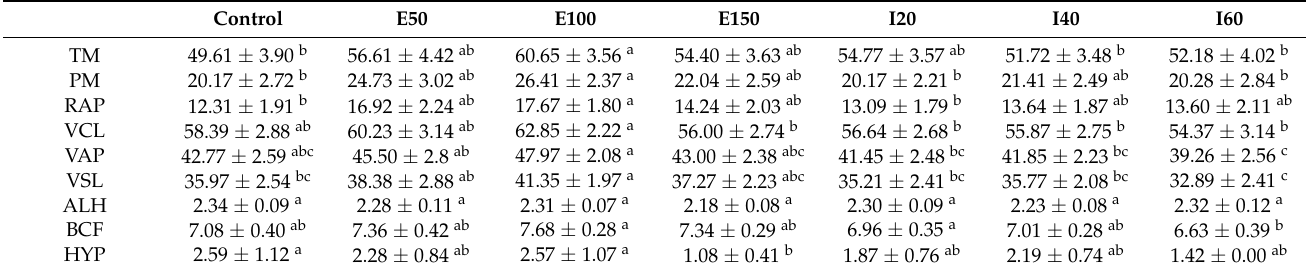
Table 2. Motility and kinetics of frozen-thawed canine semen.